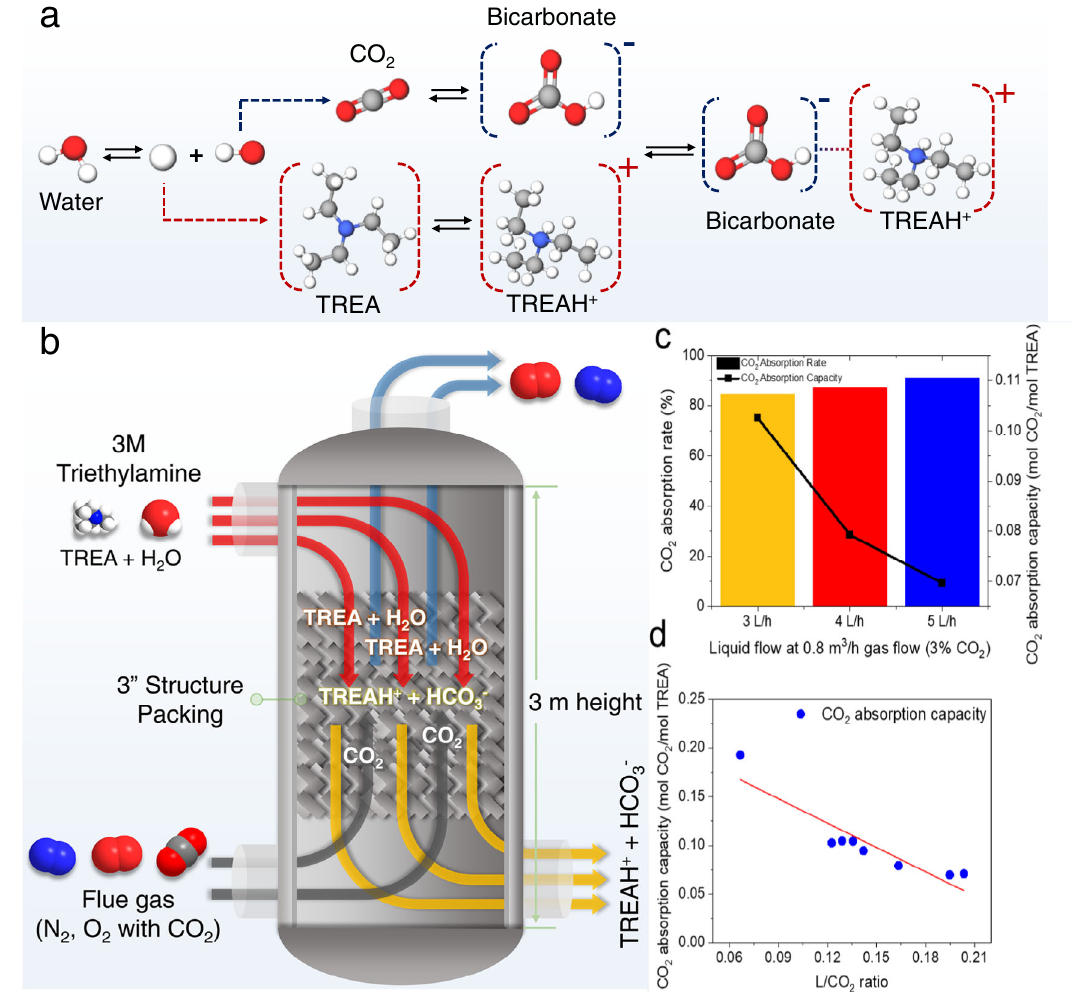
Fig. 2 | The reaction mechanism for CO 2 captured in TREA solution and CO 2 absorption performance in 3M TREA solvent. a A representation of the pro- posed CO 2 capture process is shown, where the TREA solution captures CO 2 by stabilizing the bicarbonate on anequimolar basis. b A schematic fi gure of the CO 2 absorption column used for the capture experiments. The column is 3 meters in height with a diameter of 3 inches. c CO 2 absorption experiment results